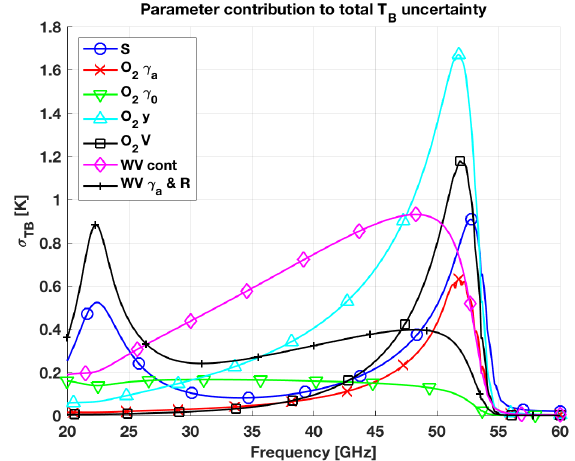
Figure 7. Contributions to zenith downwelling T B uncertainty ( σ ( T B ) ) due to the different types of O 2 and H 2 O absorption model parameters. Tropical climatology conditions are used here. The pa- rameters are grouped into seven types: intensity S (for both O 2 and H 2 O), O 2 line width γ a , O 2 zero-frequency line width γ 0 , O 2 line mixing ( y ), O 2 line-mixing temperature dependence ( V ), H 2 O con- tinuum, H 2 O line width γ a , and shift-to-width ratio R